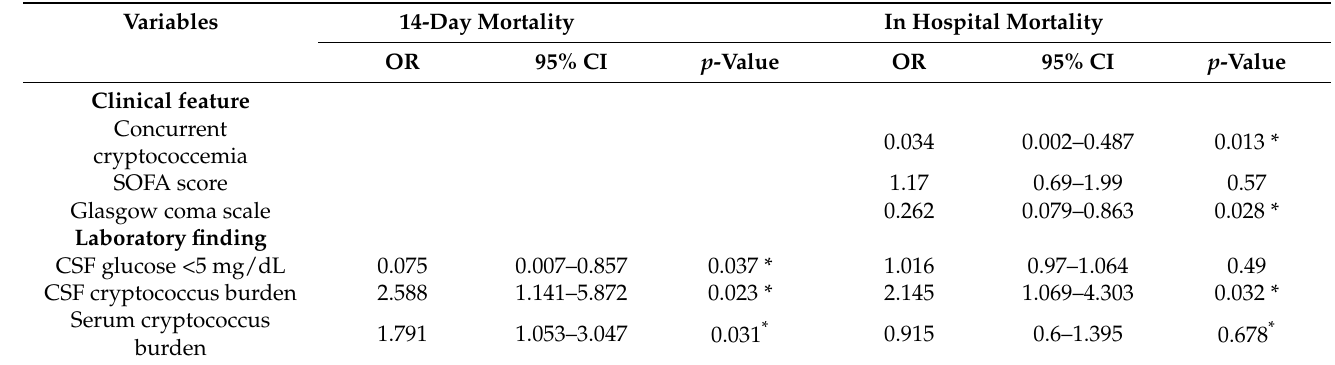
Table 5. Multivariate analysis of factors associated with unfavorable